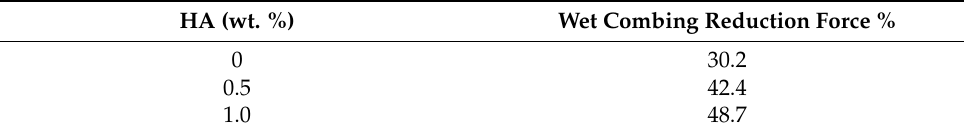
Table 4. Effect of HA Concentration with APG on Wet Combing Reduction Force.